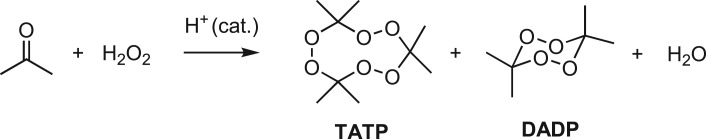
Synthesis of TATP.